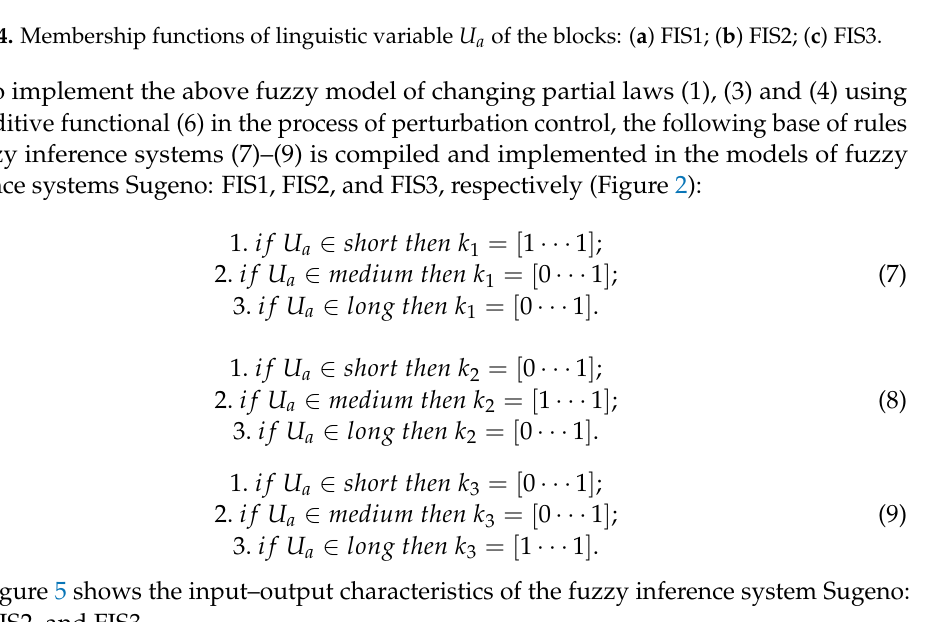
( c ) Figure 5. Dependences of fuzzy systems: ( a ) FIS1; ( b ) FIS2; ( c ) FIS3. Perturbations that occur in the arc intervals and electric circuit of the AF can be di- vided into two groups: extreme deterministic perturbations, close to single ones, causing in phases the operational short circuits or arc breaks; and continuous random perturba- tions, the statistical characteristics of which change during melting. These perturbations are phase-asymmetric and arise because of the fl uctuations of arc lengths, parameters of arc intervals, and parameters of power elements of the arc furnace electric circuit. Therefore, the study of the dynamics indicators of the EM coordinates using devel- oped fuzzy model (6) of arc length control has been performed for the action of phase- asymmetric deterministic extreme perturbations and those close to them and under the action of stationary random perturbations. Random perturbations were formed in the